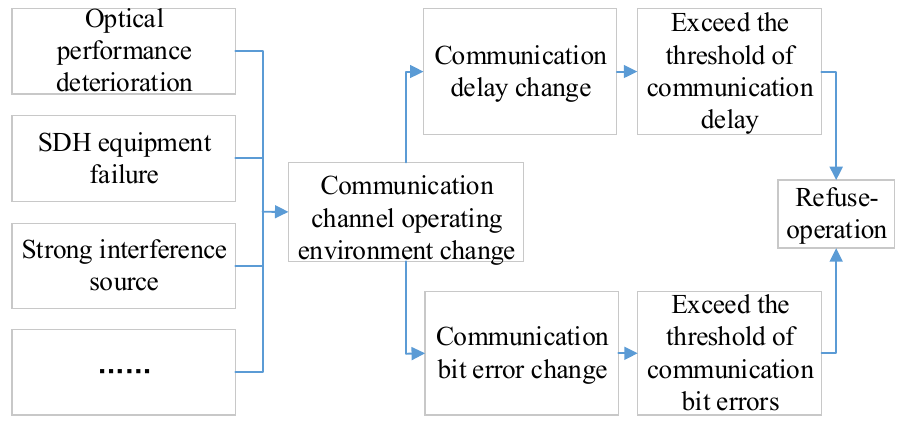
Figure 10. The progress of